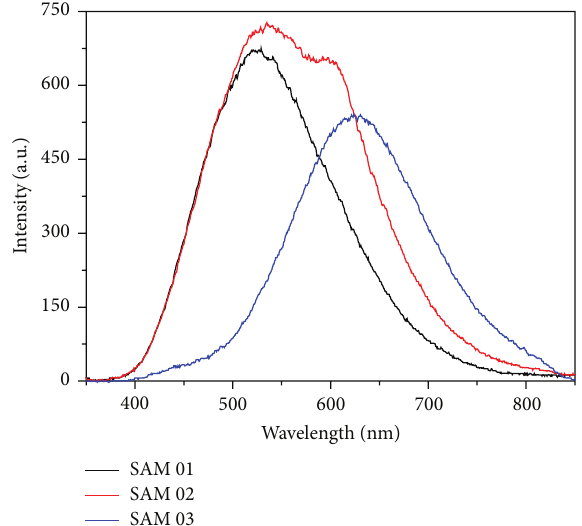
Figure 5: Fluorescence emission spectra with excitation in 350 nm of the